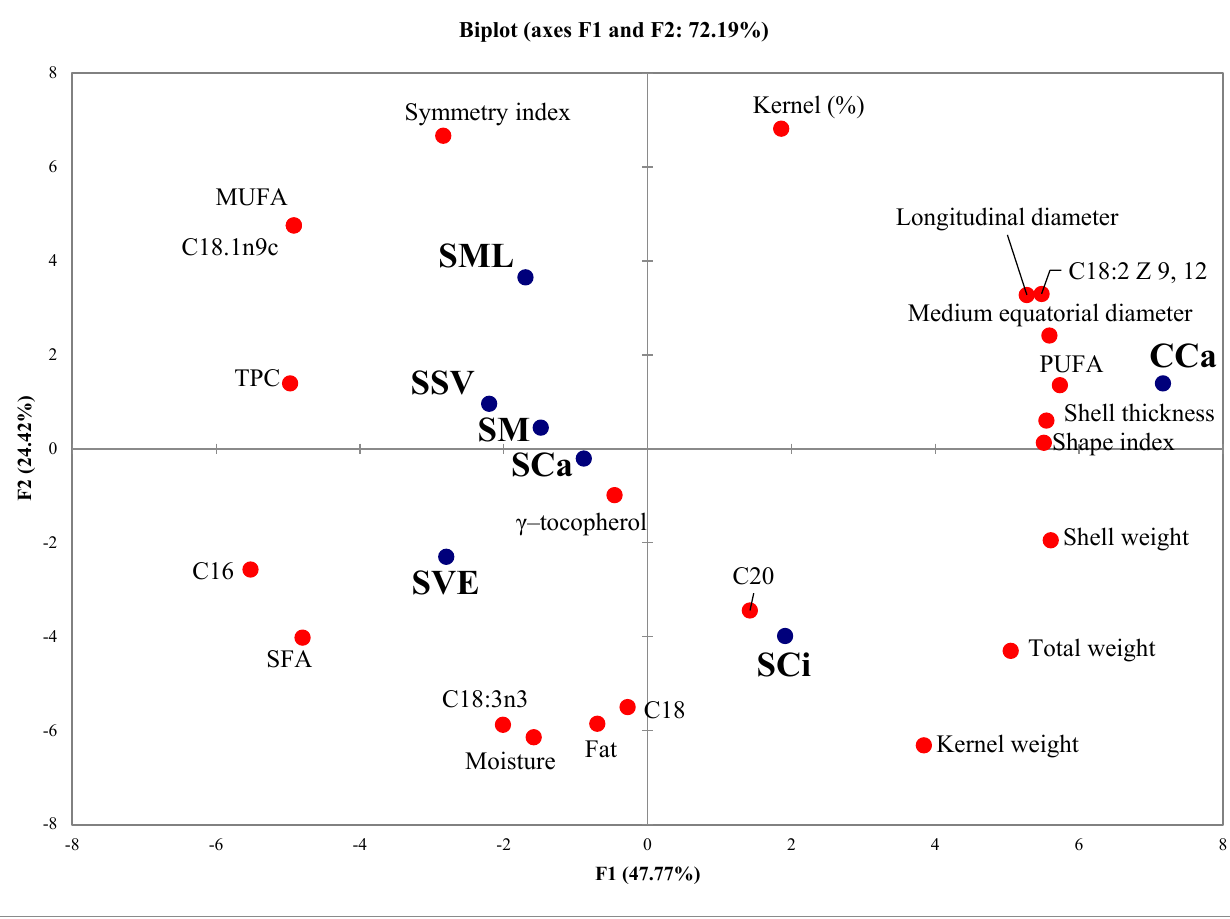
Figure 1. Results of principal component analysis (PCA) on Sorrento walnuts grown in different locations of Campania and Chandler walnut.